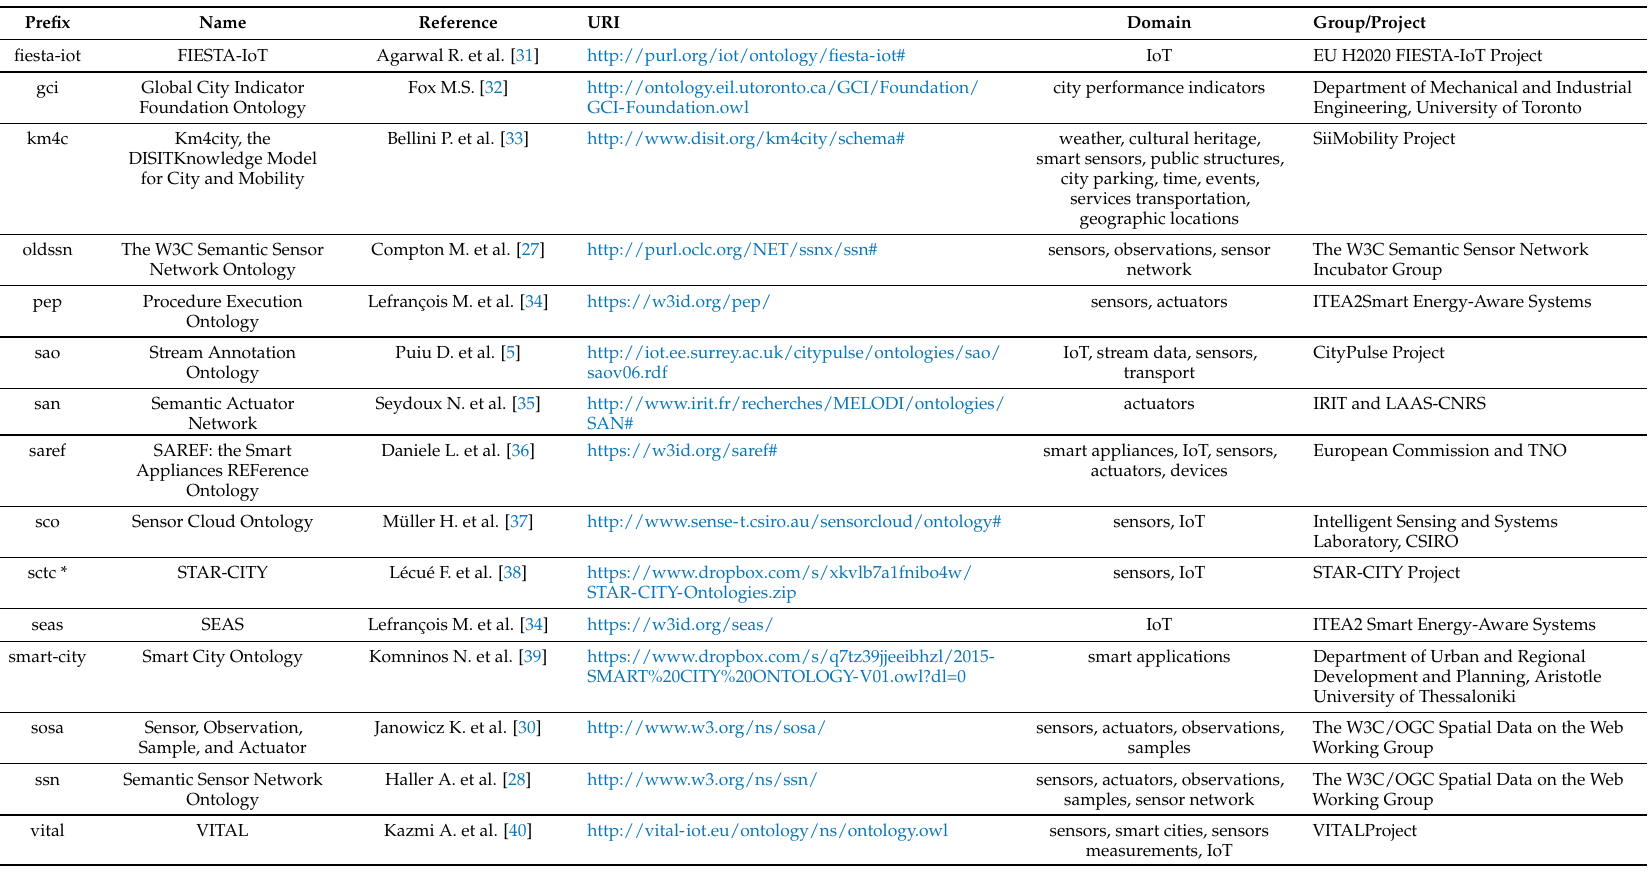
Table 3. Ontology